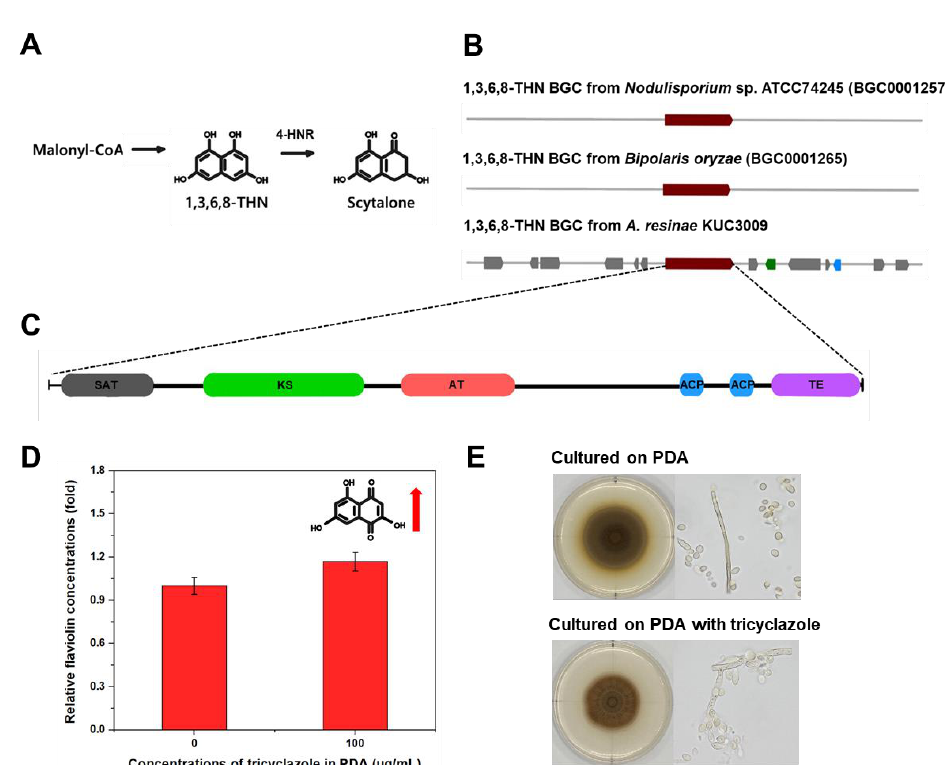
Figure 4. ( A ) Putative scytalone synthesis pathway of A . resinae KUC3009 ( B ) 1,3,6,8-THN BGC alignment between A. resinae and previously analyzed species. ( C ) Domain structure of the T1-PKS gene, consisting of an acyl-carrier protein transacylase (SAT) domain in gray, a β-ketoacyl synthase (KS) domain shown in green, an acyltransferase (AT) domain in pink, two acyl carrier protein (ACP) domains in blue, and a thioesterase (TE) domain in purple. ( D ) Comparison of flaviolin content in A. resinae mycelia cultured on PDA and tricyclazole-supplemented PDA (100 µg/mL). ( E ) Comparison of morphological properties of A. resinae cultured on PDA and tricyclazole-supplemented PDA (100 μg/mL).